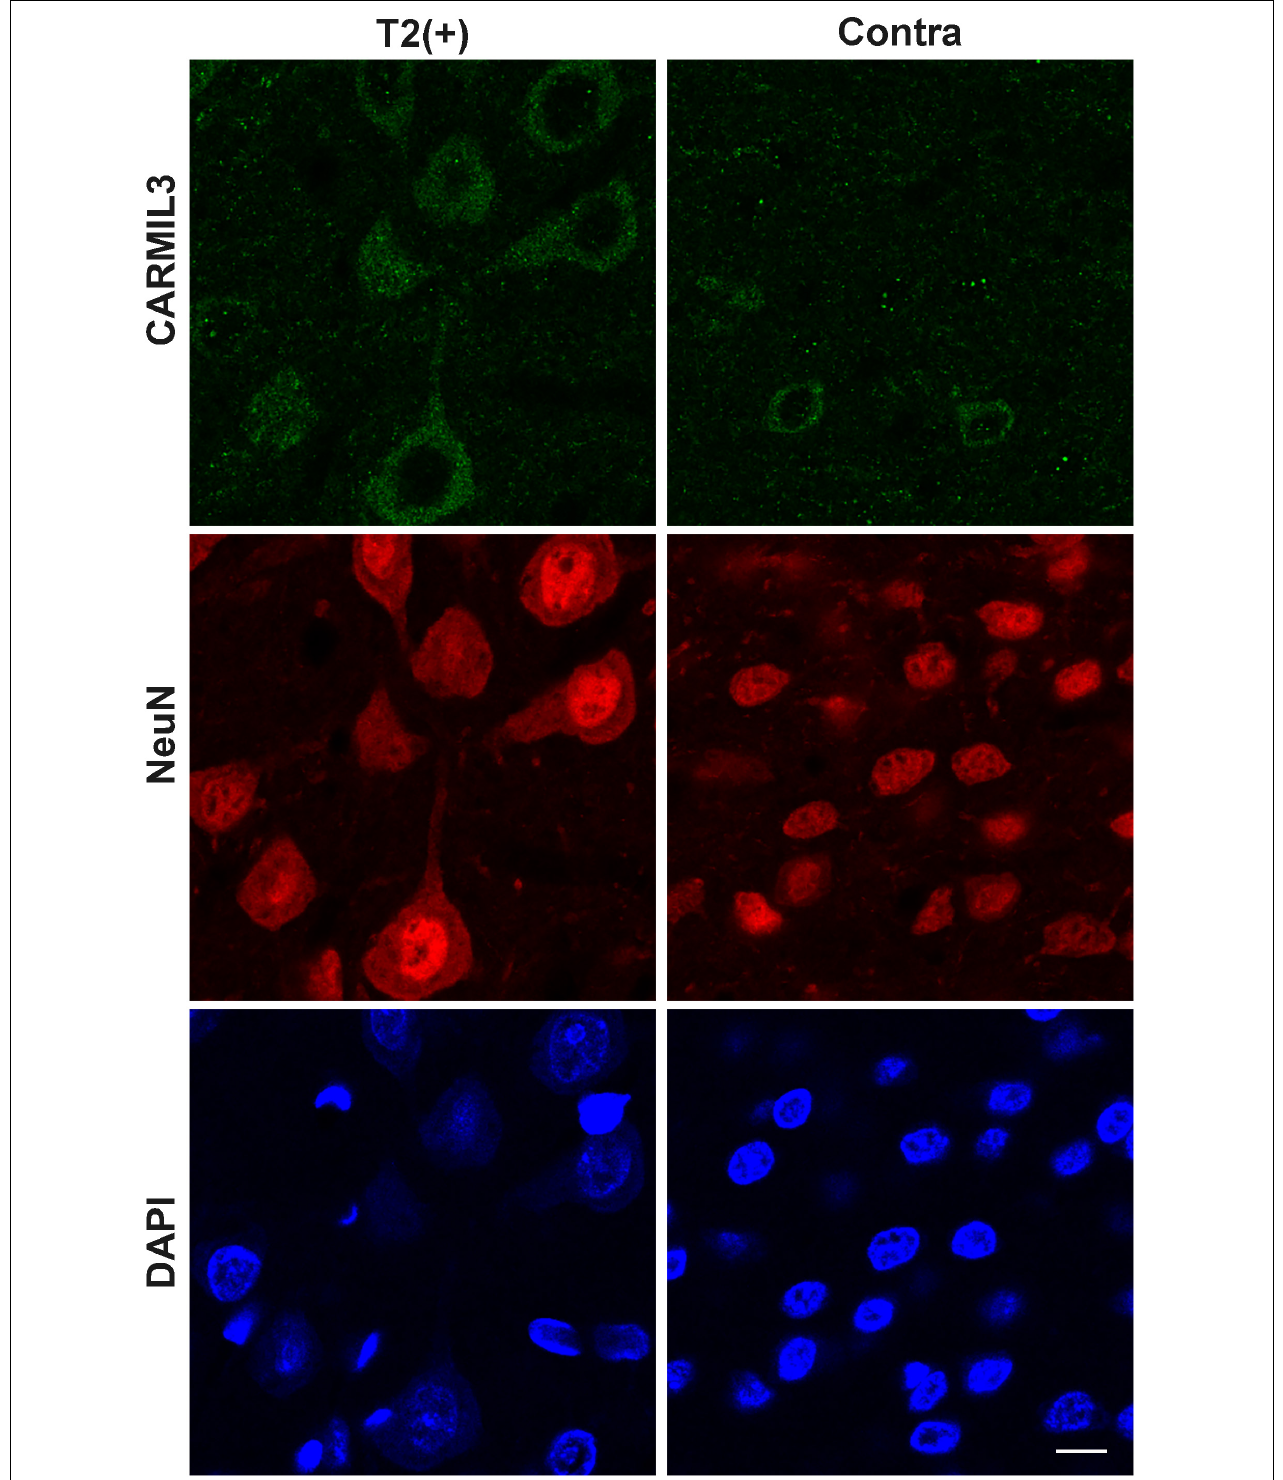
FIGURE 10 | Immunofluorescence staining of CARMIL3 in rat brains after pMCAO for 3 days. CARMIL3 expression at T2(+) and contralateral regions in the rat brains after pMCAO for 3 days. There were only minimal mismatch areas, thus they were not assessed. Many neurons in the T2(+) regions were swelling or deformed. CARMIL3 was expressed in more neurons at T2(+) regions compared with the contralateral regions, although the signal intensities of CARMIL3 in all neurons at this stage were very low compared with those in the T2(+) regions within 4.5 h after pMCAO [comparison of CARMIL3(+) count: p = 0.011]. Scale bar = 10 µ m.